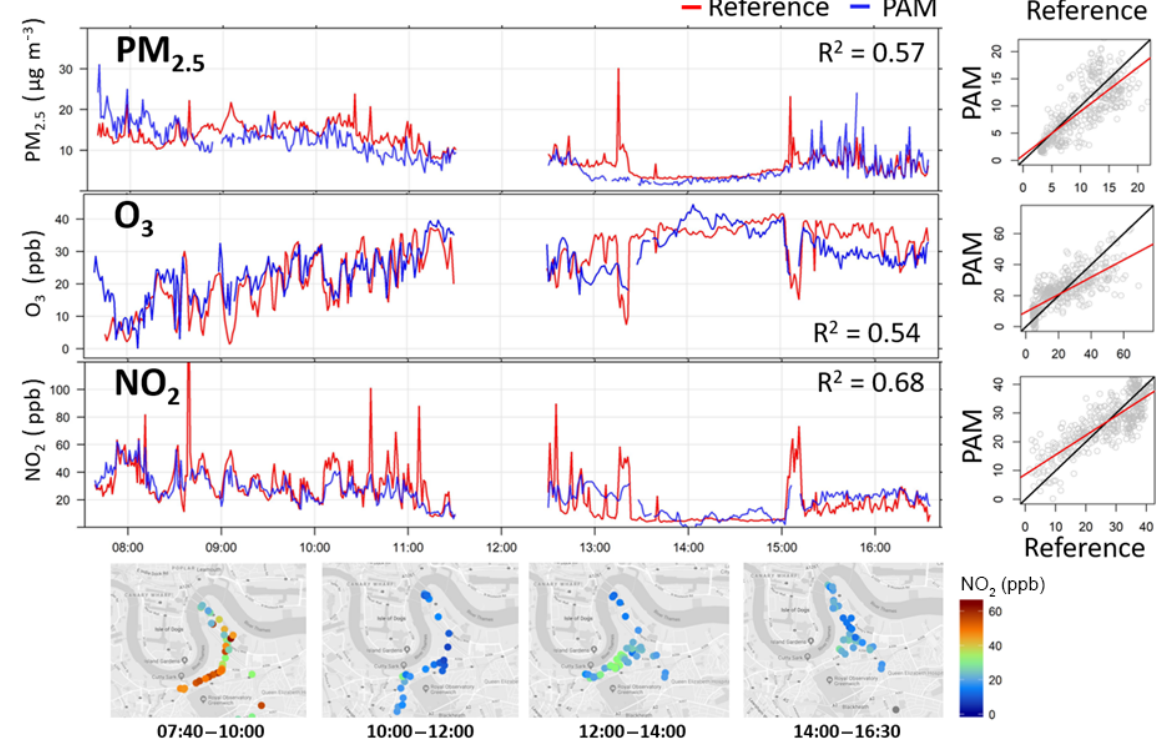
Figure 6. The vehicle deployment in London, UK: a PAM was attached to a car equipped with multiple commercial instruments (Table 2) for 1d. (a) Time series of 1d measurements of the PAM (blue) and commercial instruments (red). (b) Corresponding scatterplots between measurements from commercial instruments and the PAM in motion in an urban environment. The 1:1 line is in black, and the linear fit line is in red. (c) Maps (map data © Google 2019) of the mobile deployment over 2h windows illustrating the large temporal variability of NO 2